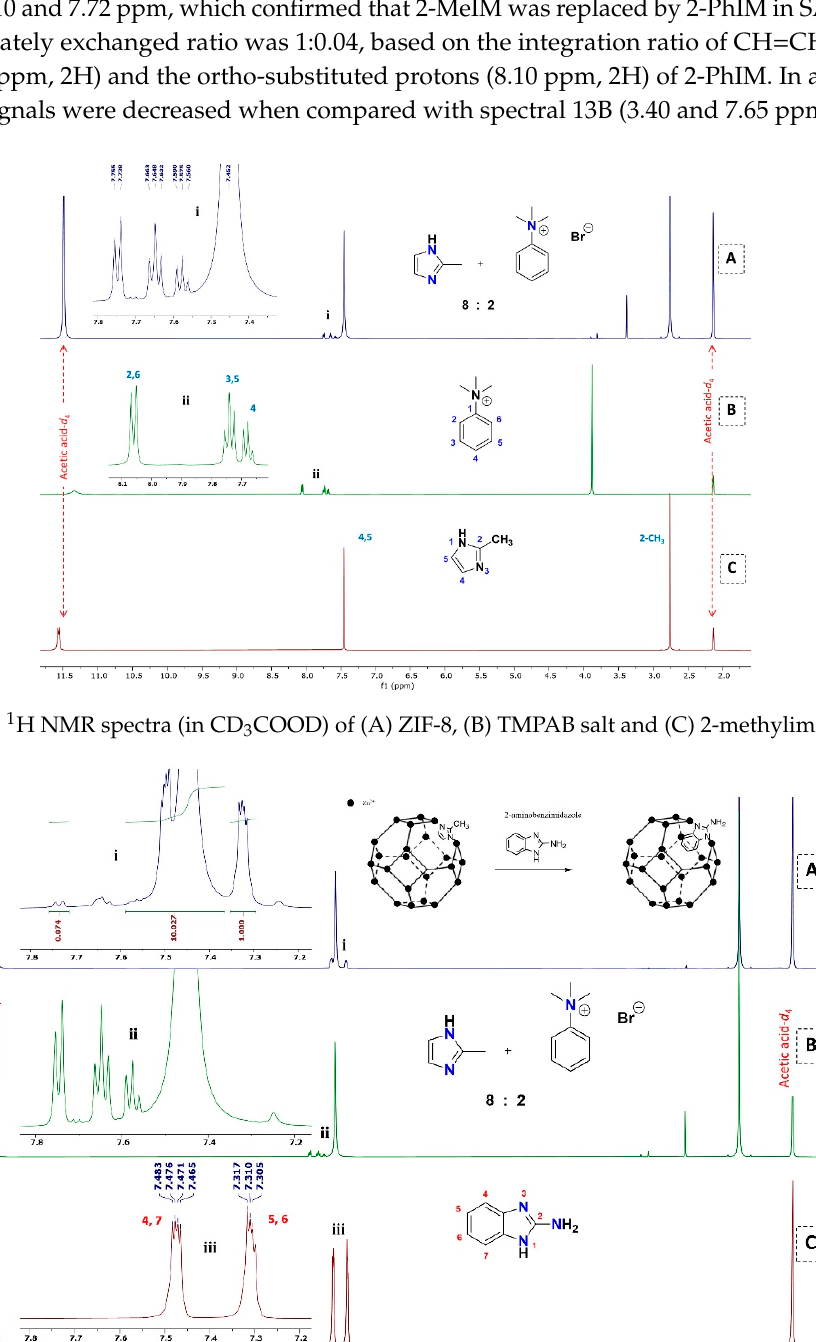
Figure 13. 1 H NMR spectra (in CD 3 COOD) of (A) exchanged ZIF-8 sample by 2-PhIM (1:3), (B) ZIF-8 and (C) 2-phenylimidazole. 3.3. CO 2 Uptake 3.3.1. CO 2 Uptake of ZIF-8 Synthesized from Water based Synthesis Assisted by Hydrogen Bond Acceptors The CO 2 uptake of all synthesized samples was measured by thermogravimetric analysis at 313 K and ambient pressure which were plotted as a function of time, as illustrated in Figure 14. The